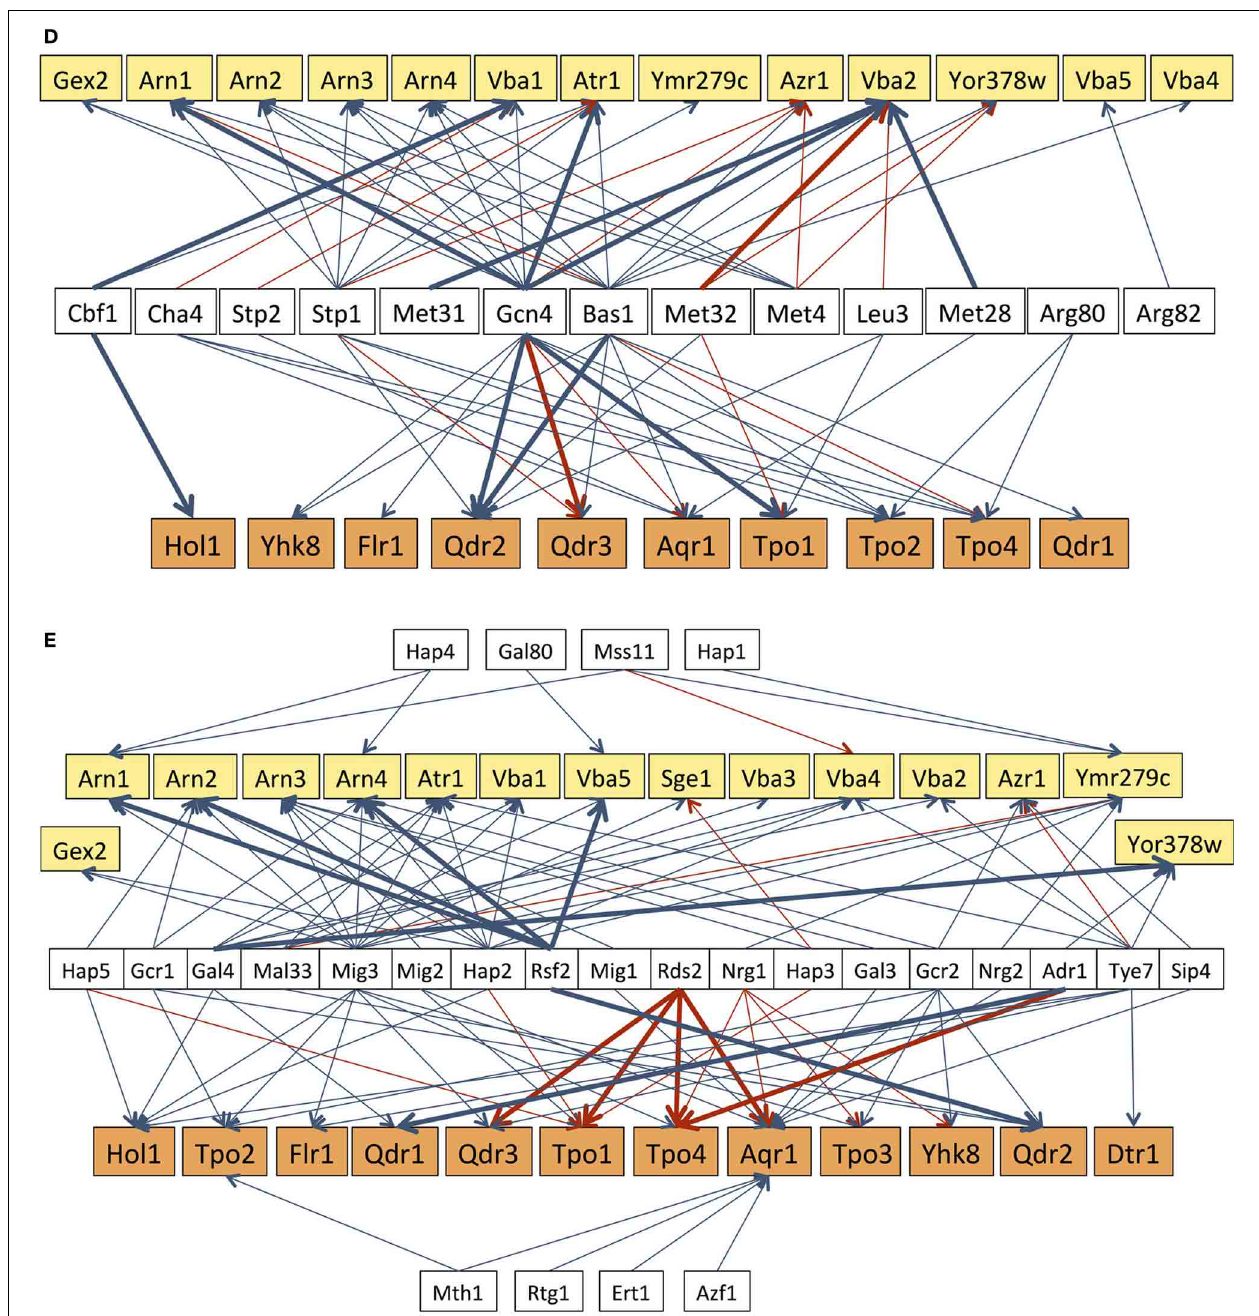
FIGURE 2 | Transcriptional regulatory networks that control the expression of DHA/DAG genes, considering the subgroups of transcription factors known to be involved in multidrug resistance (A), in stress response (B), lipid metabolism (C), or in the response to amino acid (D) and carbon source (E) availability. The displayed regulatory associations are according to the data present in the Yeastract database